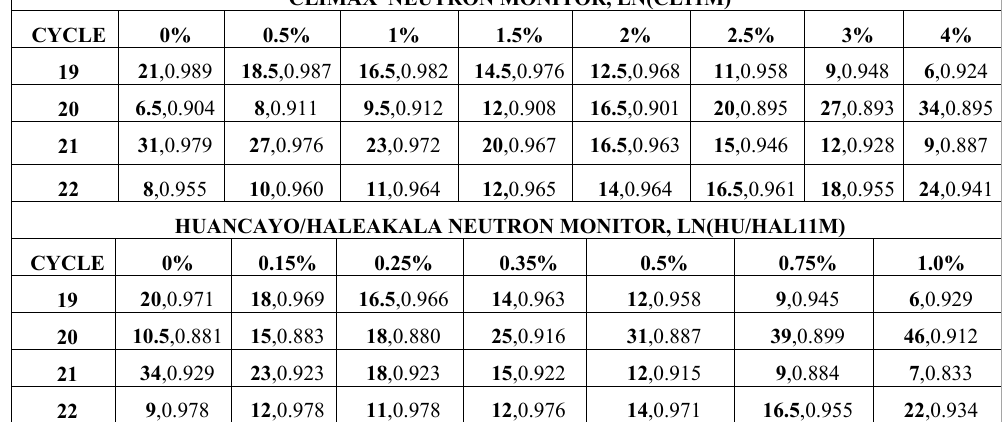
Table 1. Values of max o X (in av. months, bold) and correlation coefficients for observed data (0%) and corrected on drift effects with different amplitudes according to the 3-rd model.